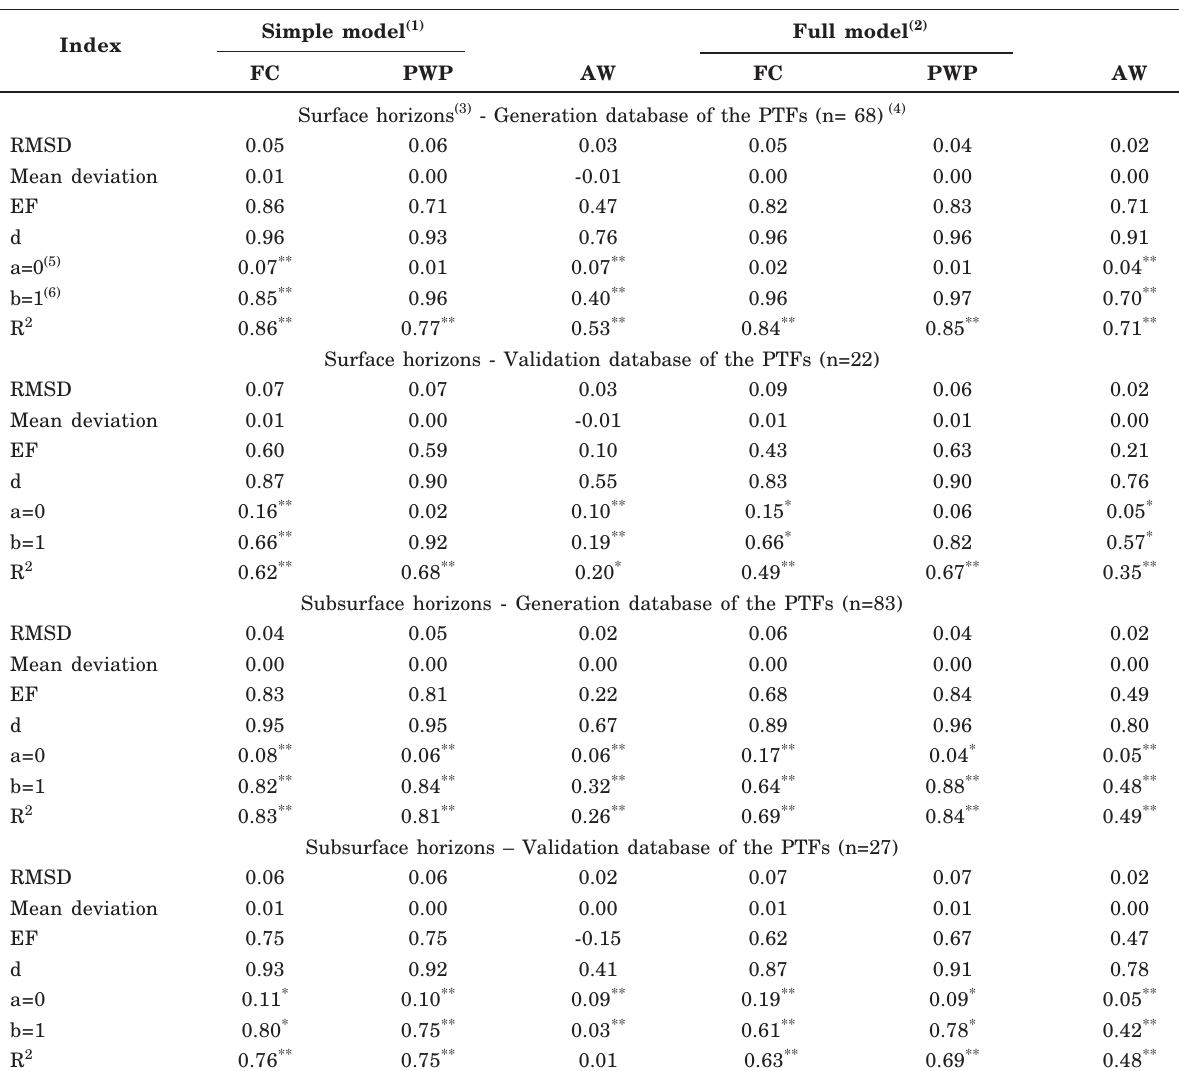
Table 7. Root mean square deviation (RMSD, m 3 m -3 ), mean deviation (MD, m 3 m -3 ), efficiency index (EF) of Nash & Sutcliffe (1970), index of agreement (d) of Willmott (1981), intercept (a, m 3 m -3 ), angular coefficient (b) and coefficient of determination (R²) for the fitted equations between measured moisture and estimated moisture for different pedotransfer functions for field capacity (FC), permanent wilting point (PWP) and available water content (AW) for soils of the State of Santa